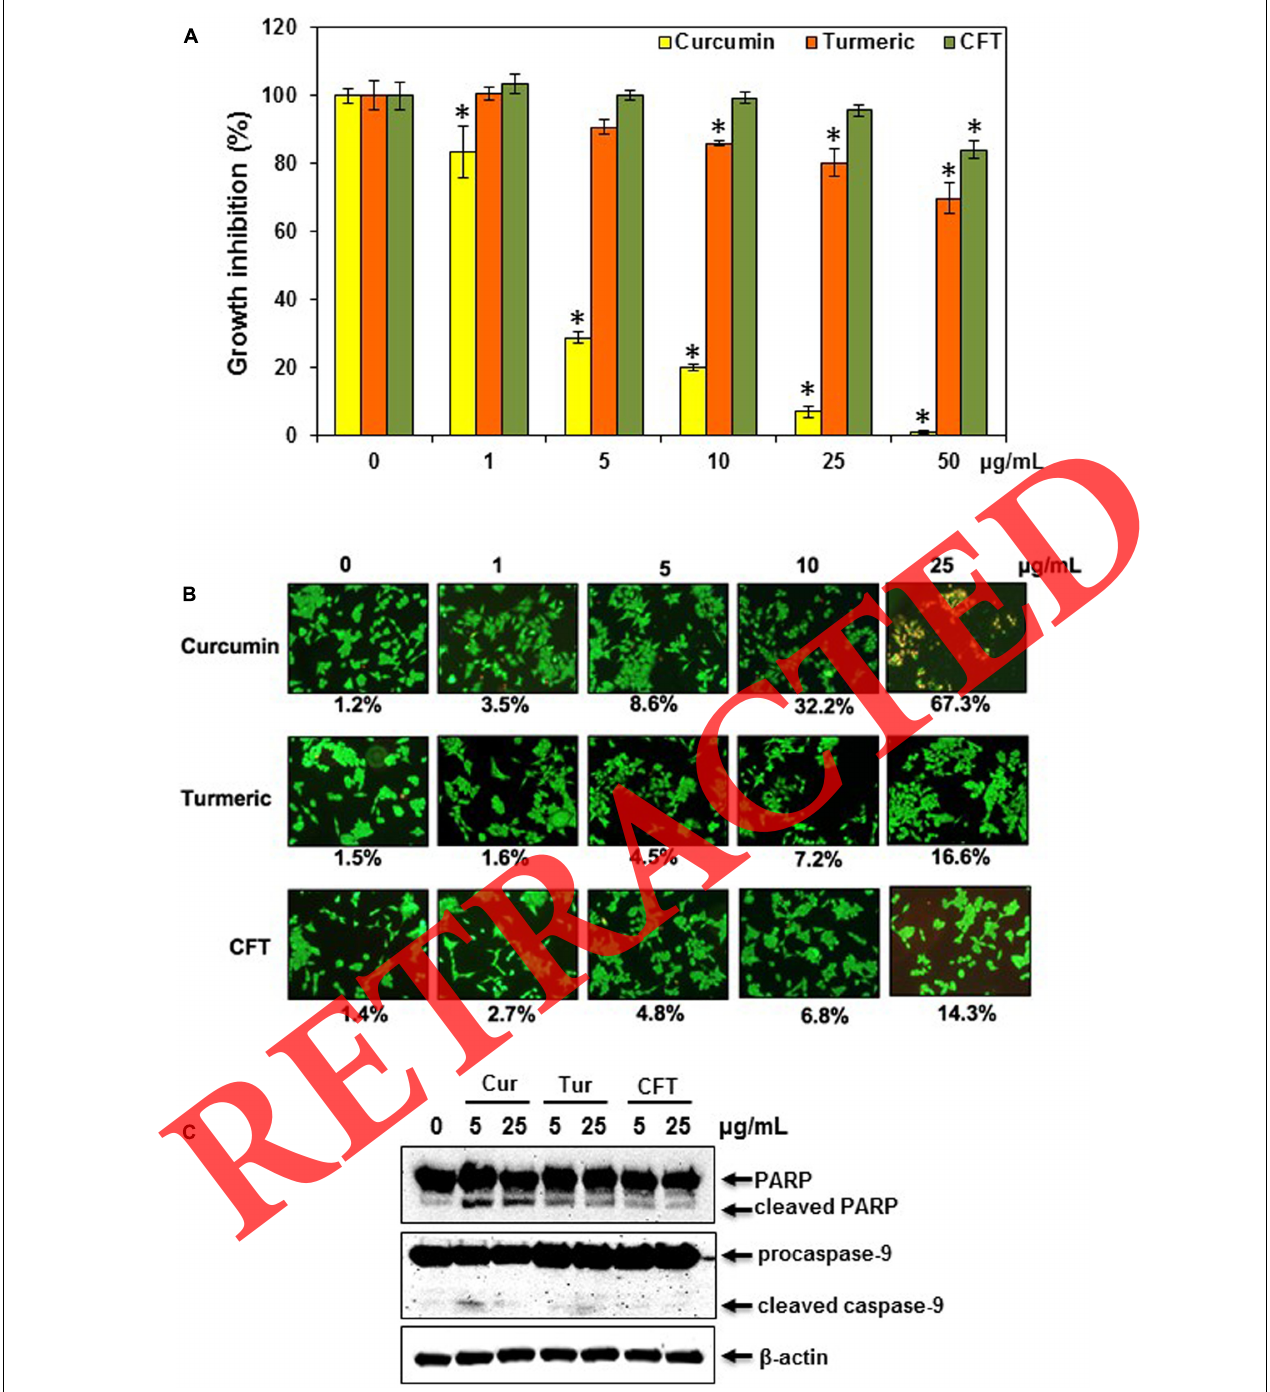
FIGURE 1 | Cytotoxic effects of curcumin, turmeric, and CFT. (A) HCT-116 cells were treated with the indicated concentrations of curcumin, turmeric, and CFT for 72 h. Growth inhibition was then analyzed by the MTT method. N = 3; ∗ P < 0.05. (B) HCT-116 cells were treated with the indicated concentration of curcumin, turmeric, and CFT for 24 h, stained with live/dead assay reagents for 30 min, and then counted using a fluorescence microscope. Cell death (%) is given below the images. (C) HCT-116 cells (1 × 10 6 /well) were treated with the indicated concentration of curcumin, turmeric, and CFT for 24 h and then harvested. Whole cell lysates were prepared and subjected to Western blotting to analyze procaspase-9 and PARP cleavage. The same blots were then stripped and reprobed with β -actin antibody to verify equal protein loading.